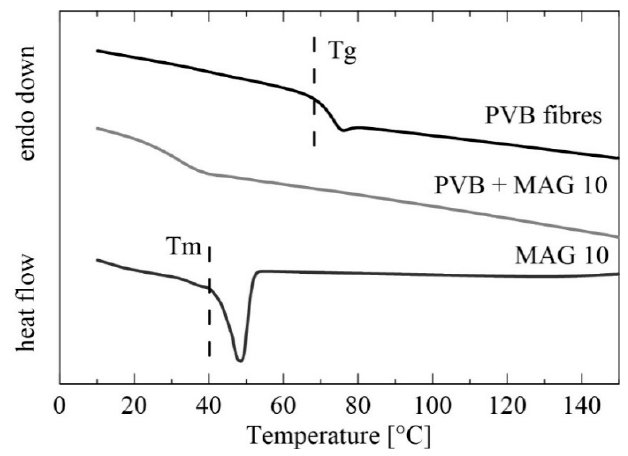
Figure 5. Differential scanning calorimetry (DSC) thermograms of MAG 10, the PVB fibers and PVB fibers with MAG 10 (first heating scan).